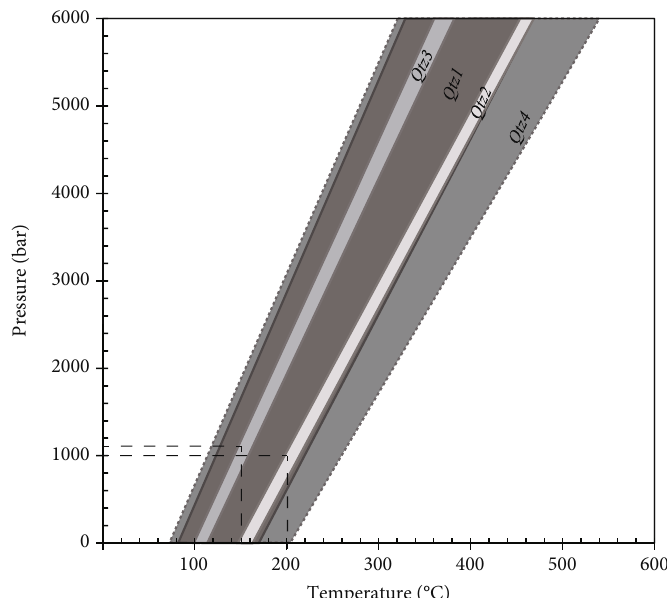
Figure 11: Representative isochores of two-phase aqueous gas-free fl uid inclusions (type 3) in the Roc Blanc mineralised quartz veins. Isochores are calculated after the model of Zhang and Frantz